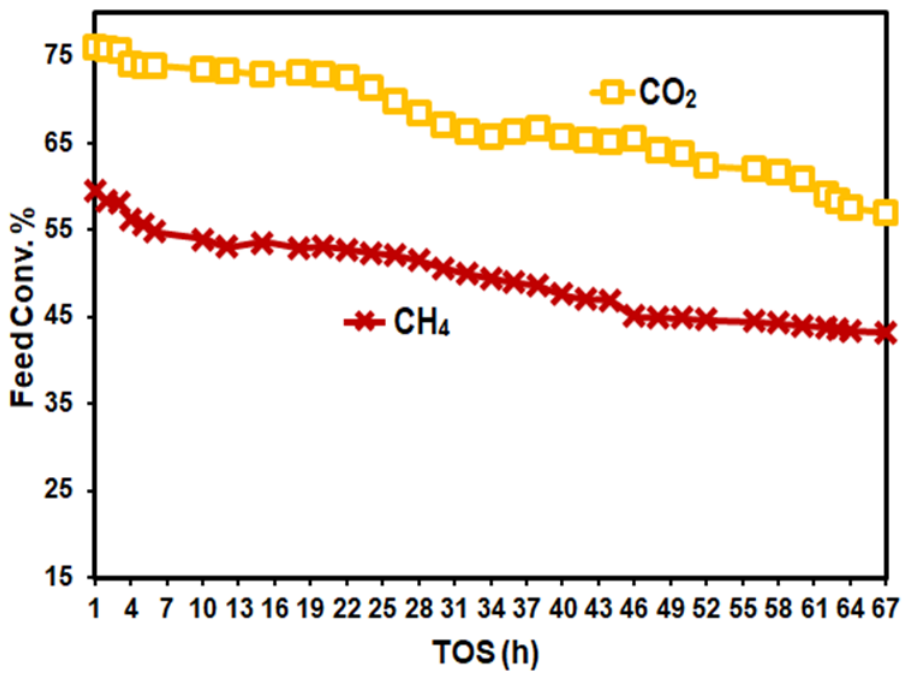
◦ C, and GHSV = 42 l / (h.g cat